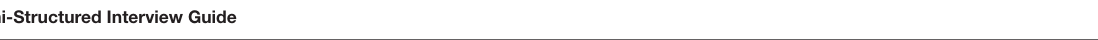
TABLE 1 | Semi-structured interview guide. Semi-Structured Interview Guide